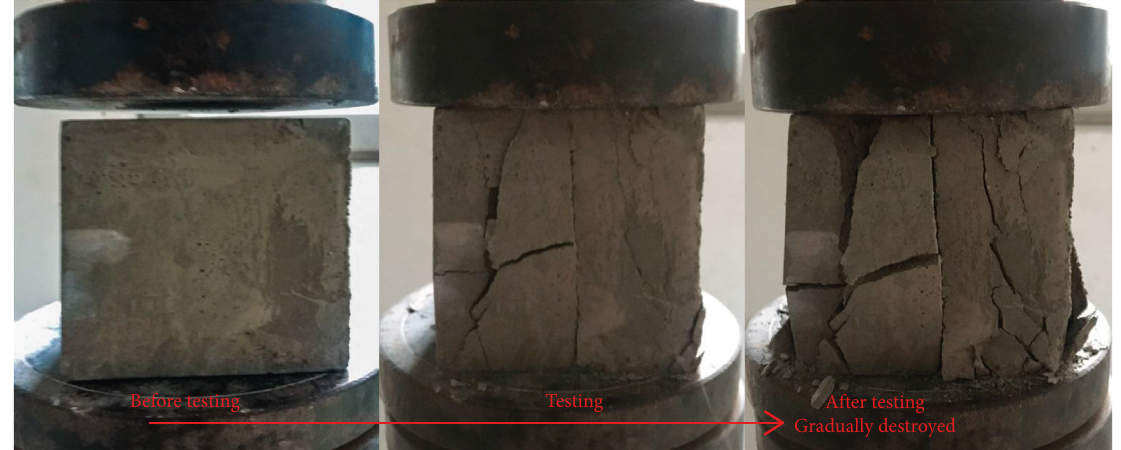
Figure 6: UCT and destruction process of a 28-day SPCTB specimen containing 10% stone